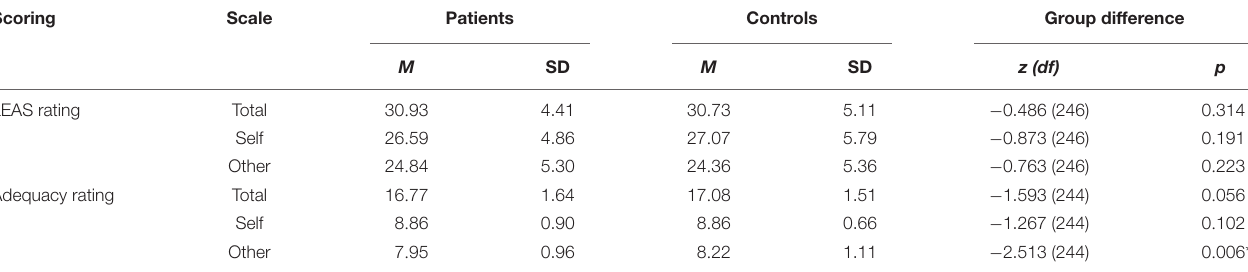
TABLE 3 | Comparison of conventional LEAS and adequacy mean scores of patients and control group. Scoring Scale Patients Controls Group difference